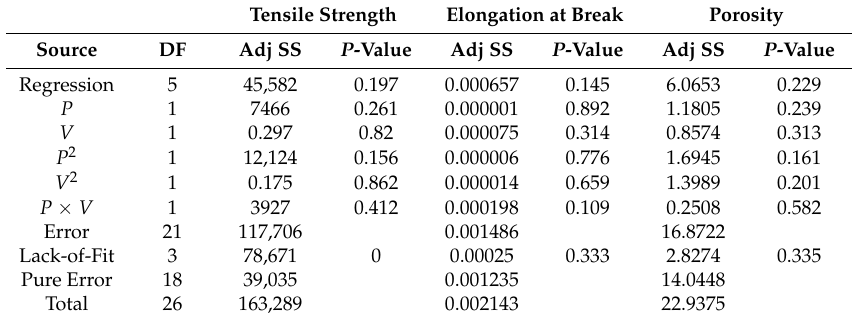
Table 2. Full ANOVA table of the mechanical properties for first order, second order, and interaction terms. Tensile Strength Elongation at Break